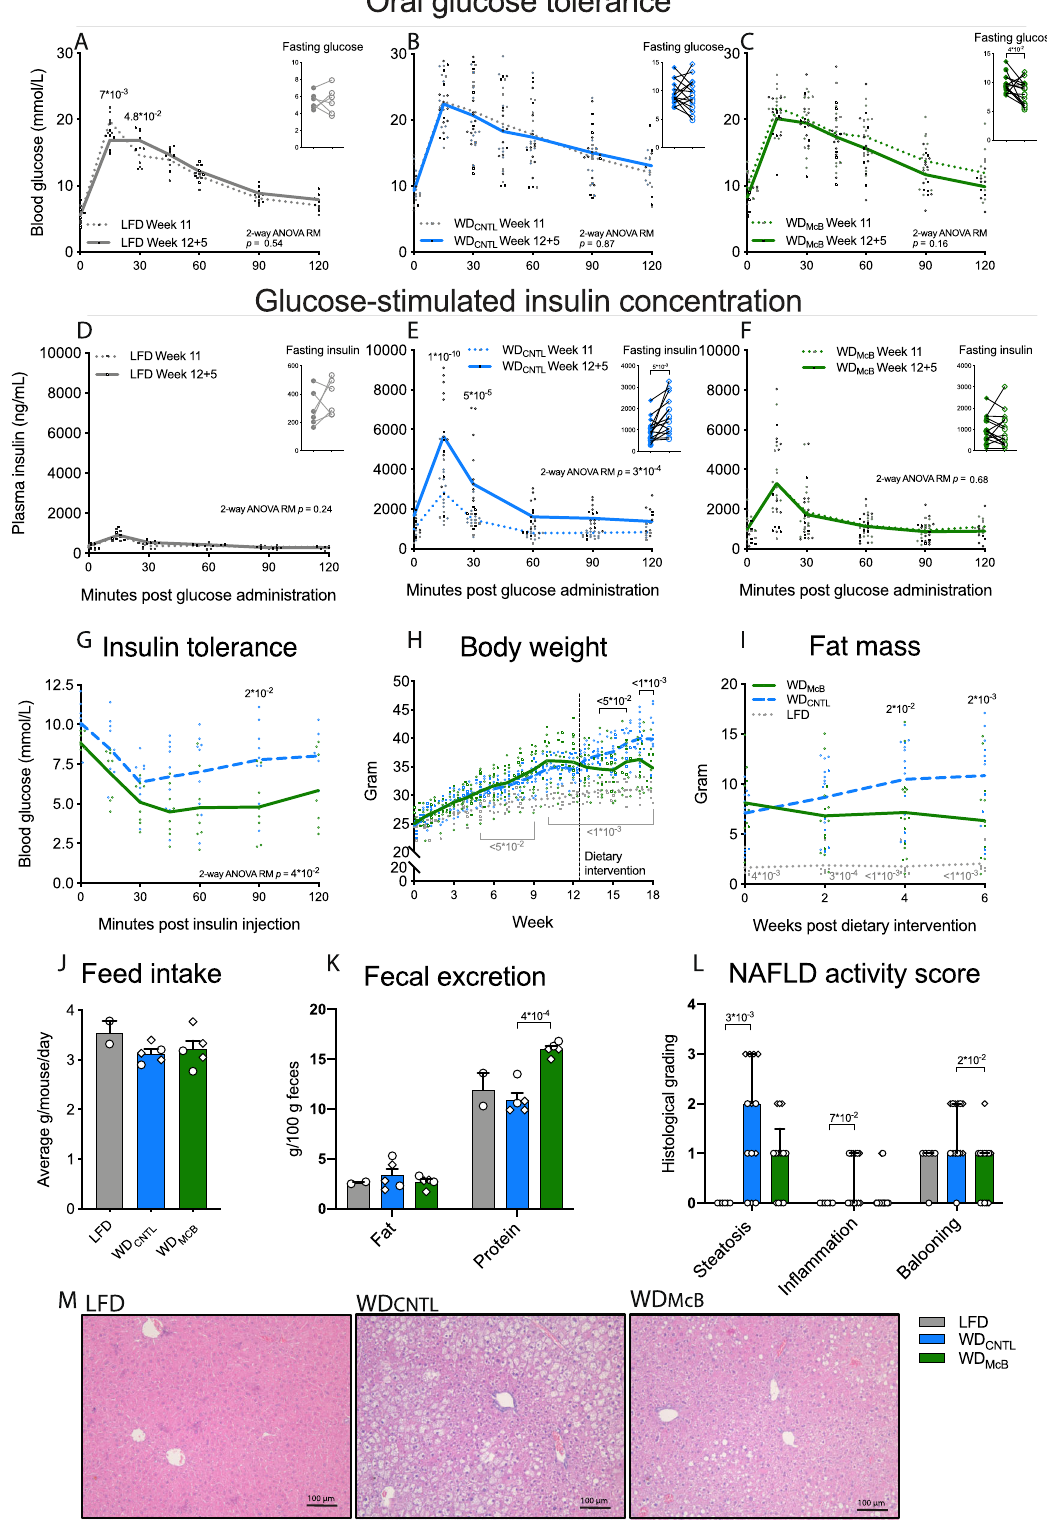
instrumental in de novo lipogenesis at the onset of metabolic syndrome 33